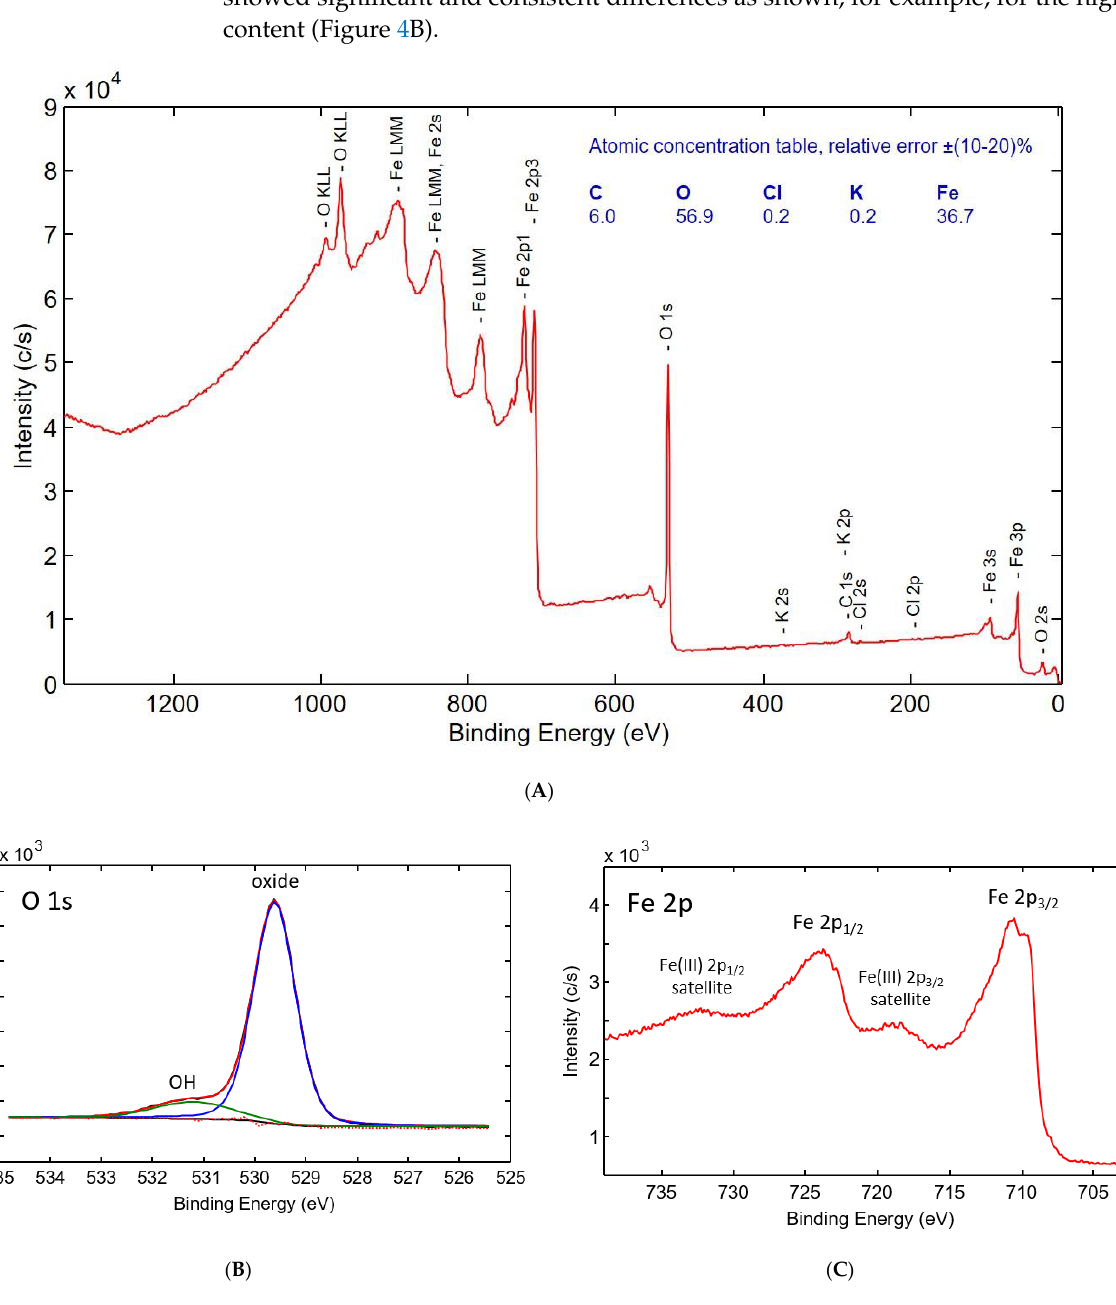
Figure 2. XPS data for the synthesized solid phase. ( A ) survey scan; ( B ) narrow scan of O 1s elemental line, curve fit of the spectrum shown by colored lines: red, overall; green, hydroxide peak; blue, oxide peak; ( C ) narrow scan of Fe 2p elemental lines.